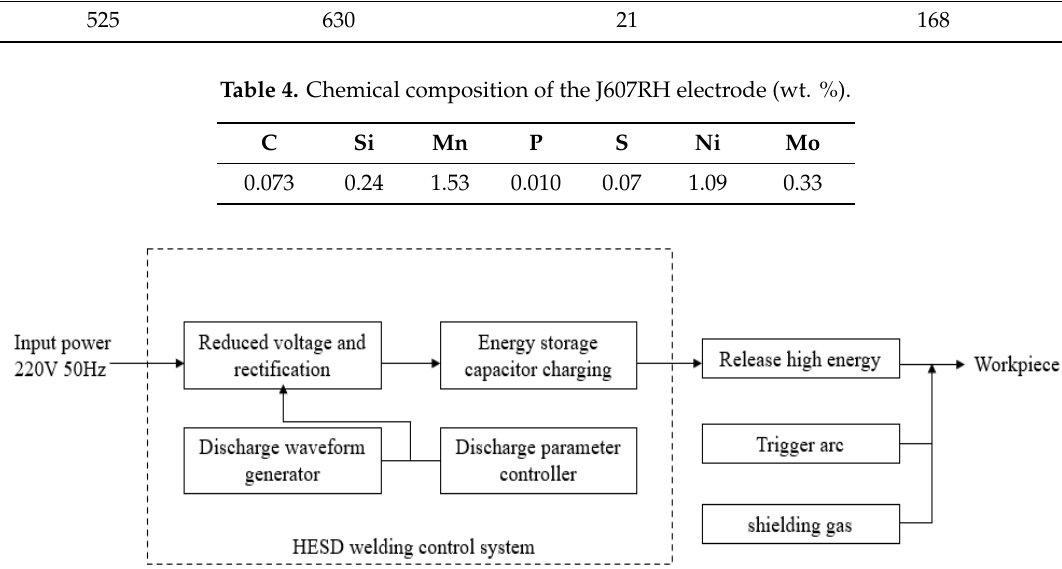
Figure 2. Schematic of the JYPSD-2 HESD welding machine working principle.